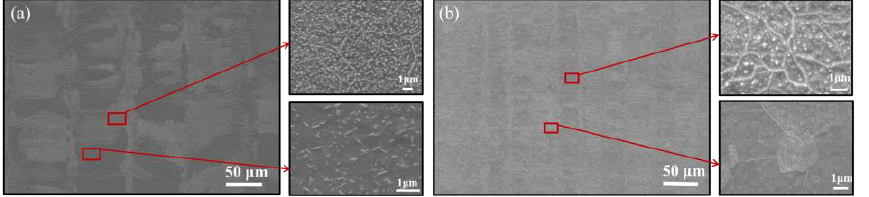
Figure 6. SEM images observed from the top view. ( a ) 200 W power and 800 mm/s scanning velocity; ( b ) 320 W power and 800 mm/s scanning velocity.